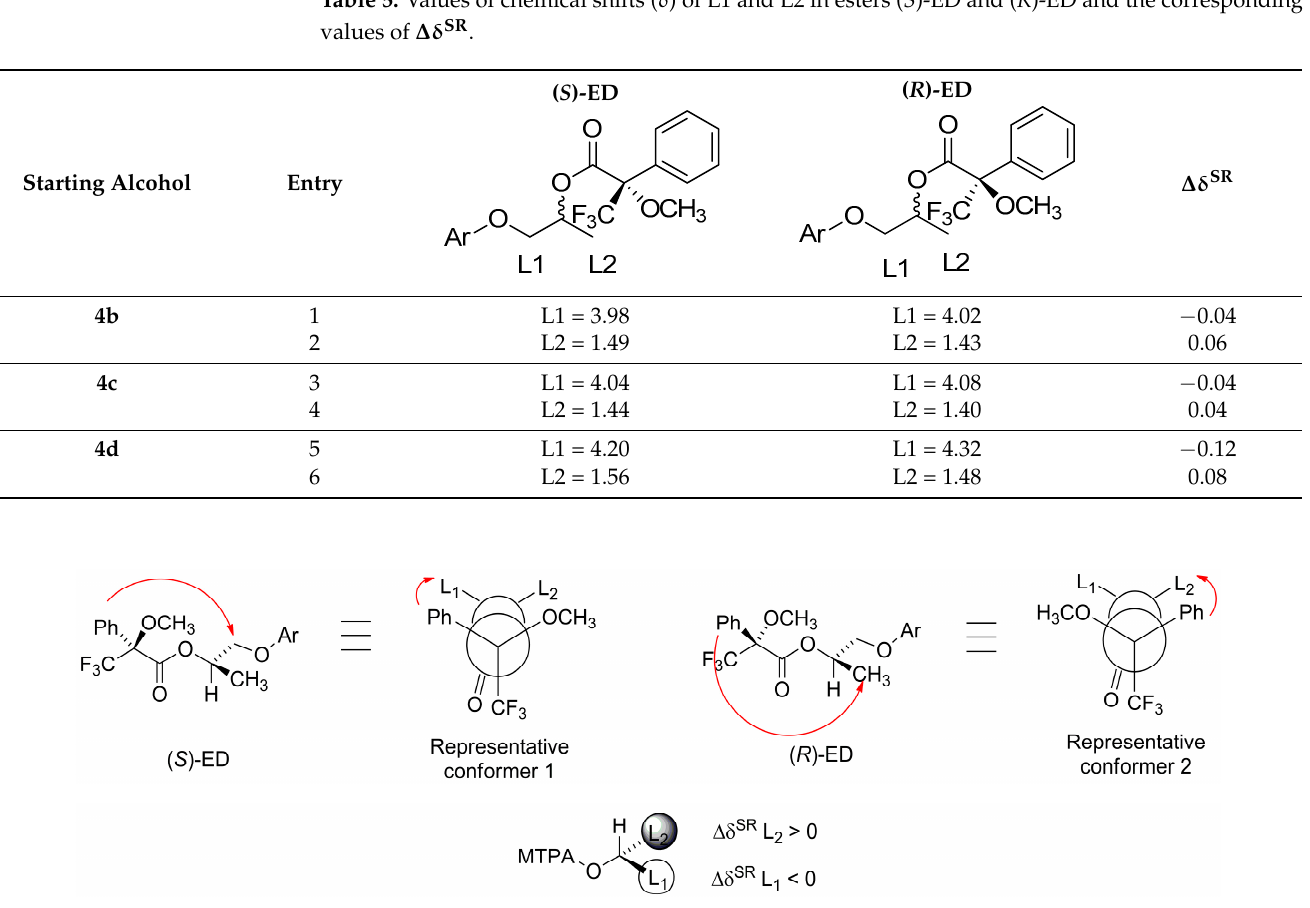
Figure 2. Mosher models [40] for the assignment of configurations of alcohols 4b-d by 1 H NMR using ∆δ SR .